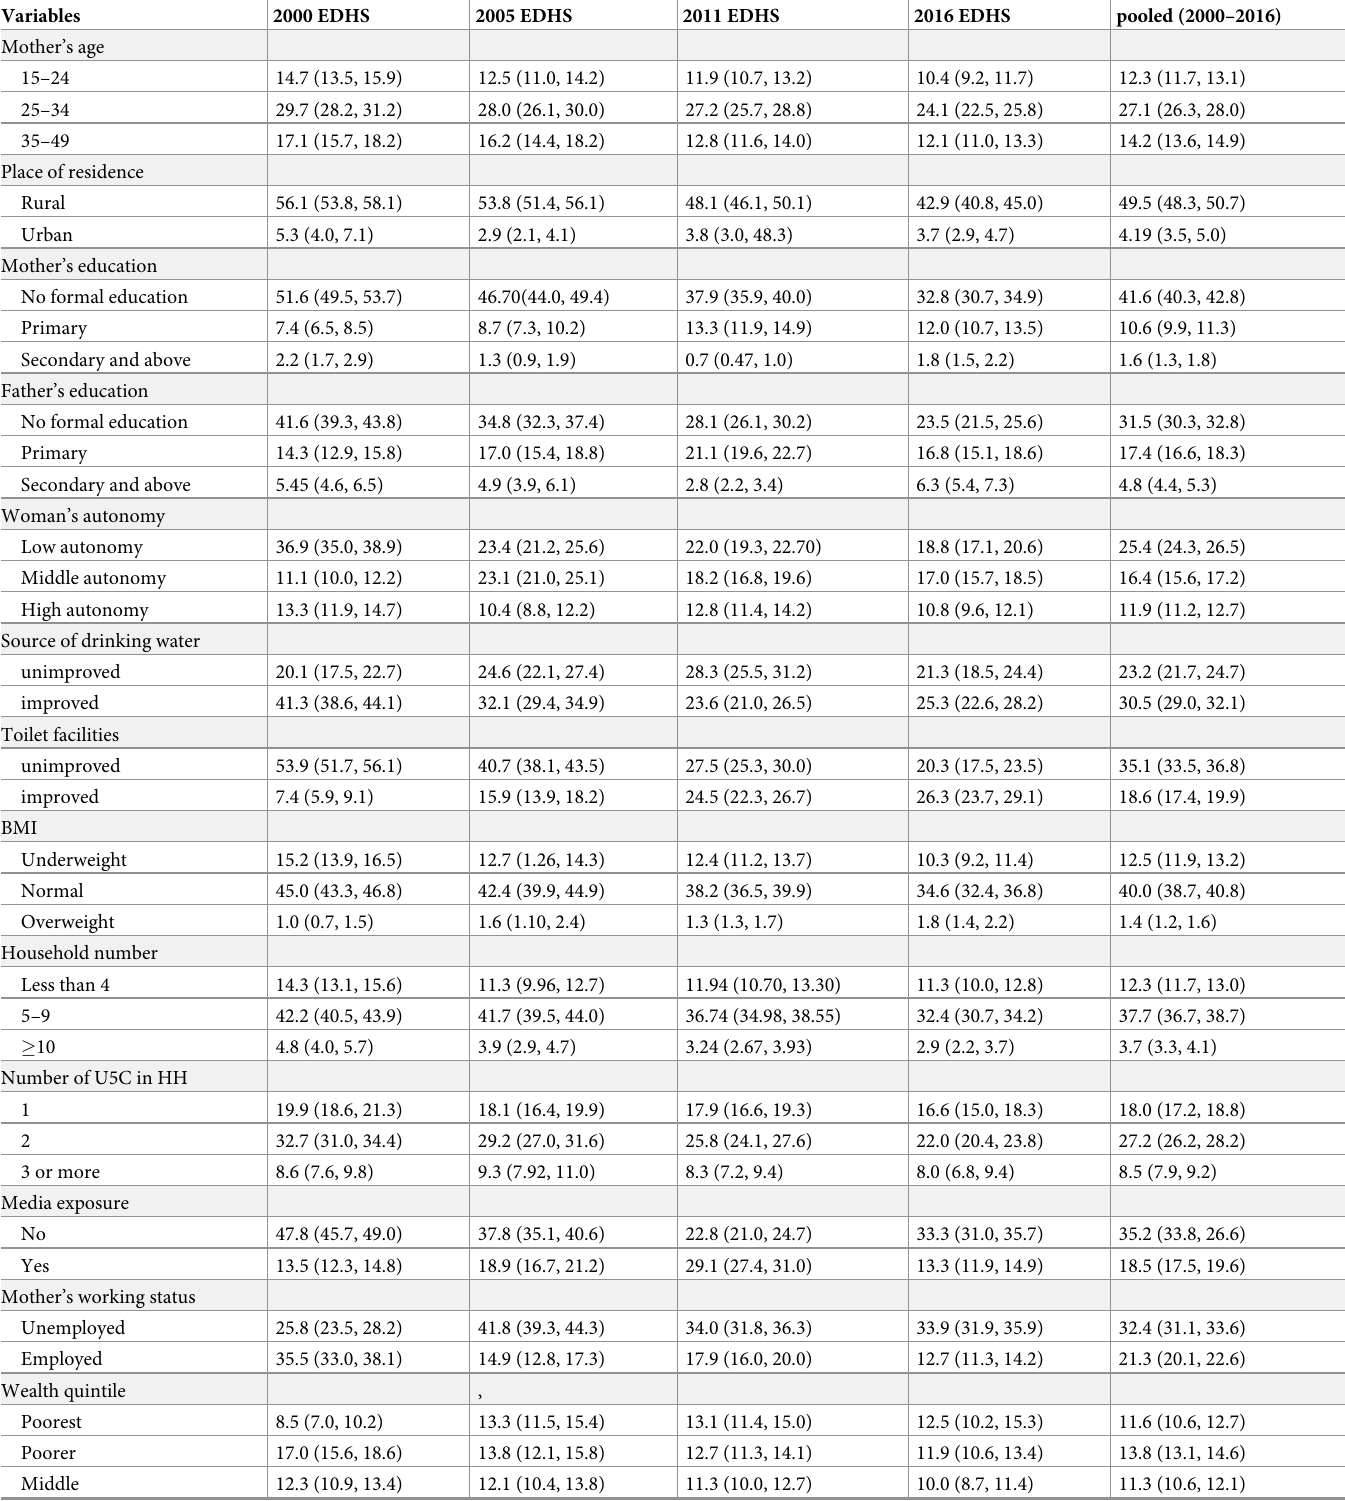
Table 3. Prevalence with 95% CI of CIAF with respect to household characteristics in Ethiopia for EDHS (2000, 2005, 2011, and